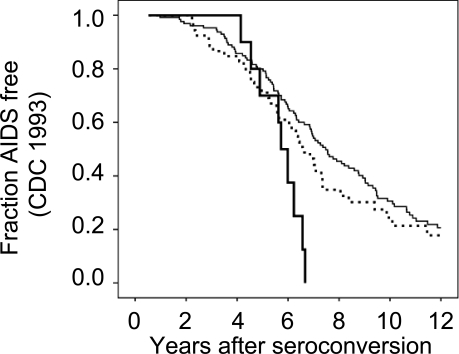
Survival Analysis for the −2G/C Genotype in Combination with the 136Q GenotypeKaplan Meier analysis for time in years from seroconversion to AIDS according to the CDC 1993 definition. Bold black lines indicate individuals with the −2GG genotype; dashed black lines indicate individuals with the −2GC genotype; thin black lines indicate individuals with the −2CC genotype.